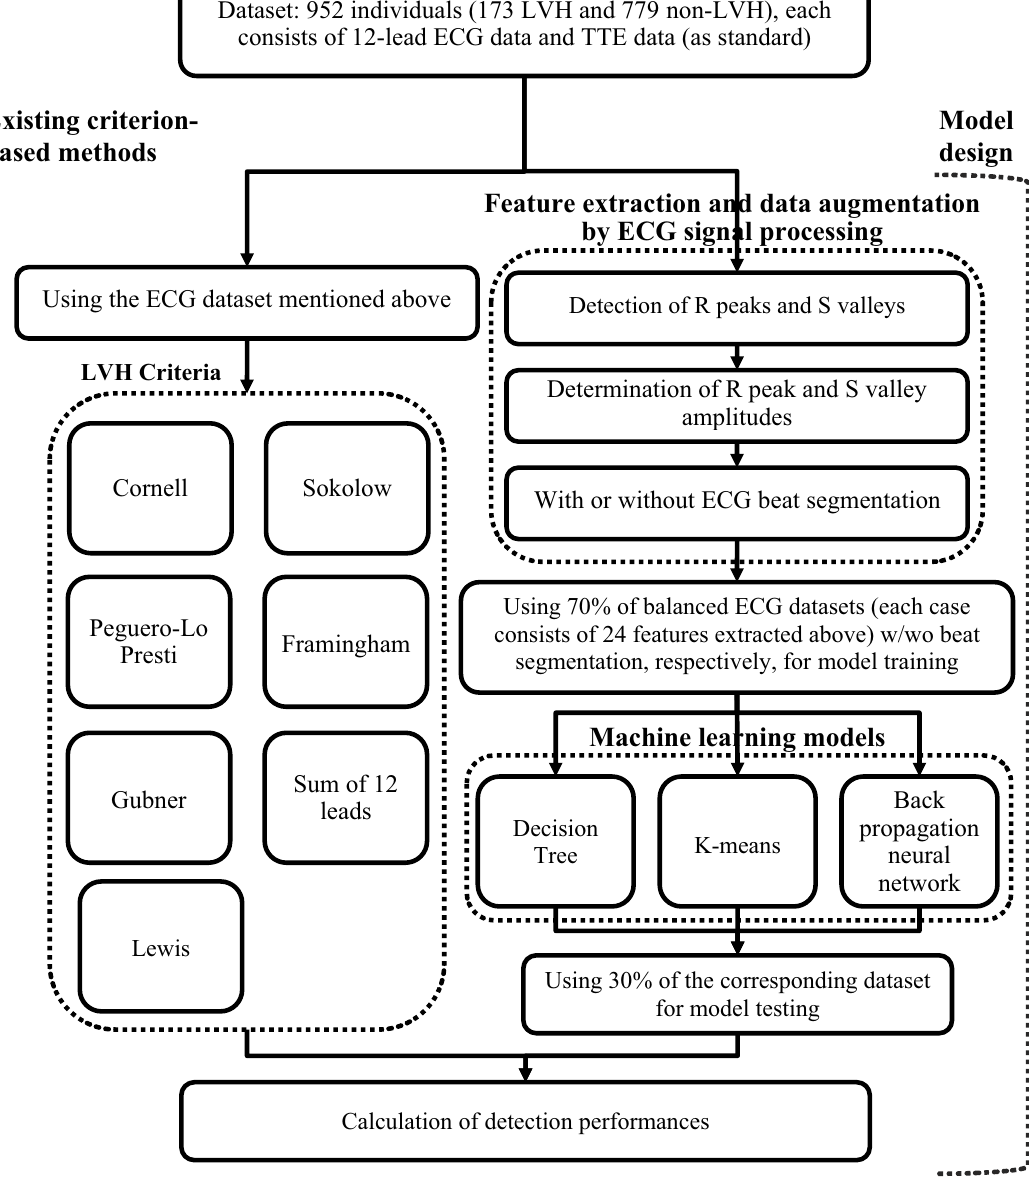
Figure 1. The system architecture of LVH detection.